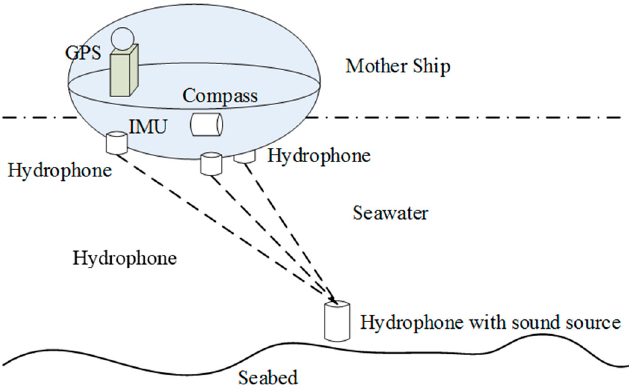
Figure 1. Positioning of the seabed hydrophone.